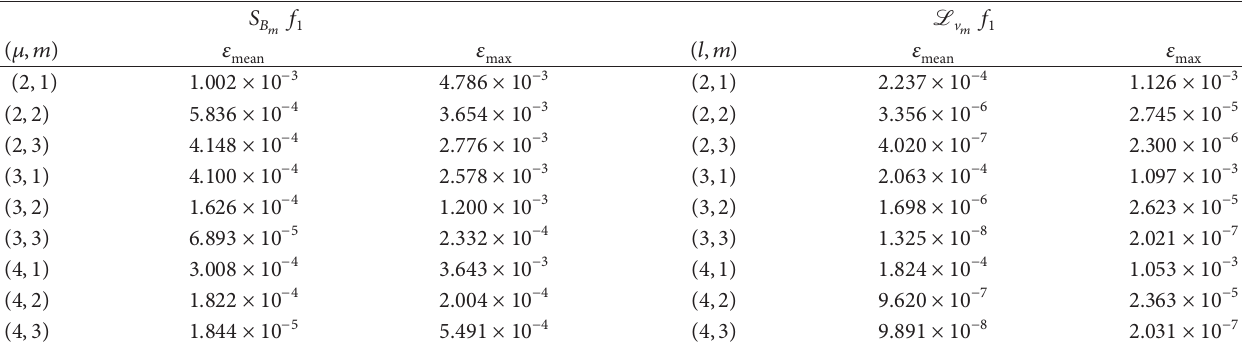
and L V for the saddle function. 𝑚 𝑚